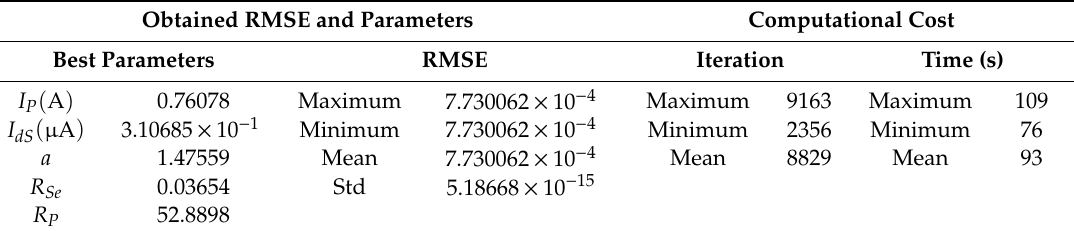
Table 1. Results for the single-diode cell.